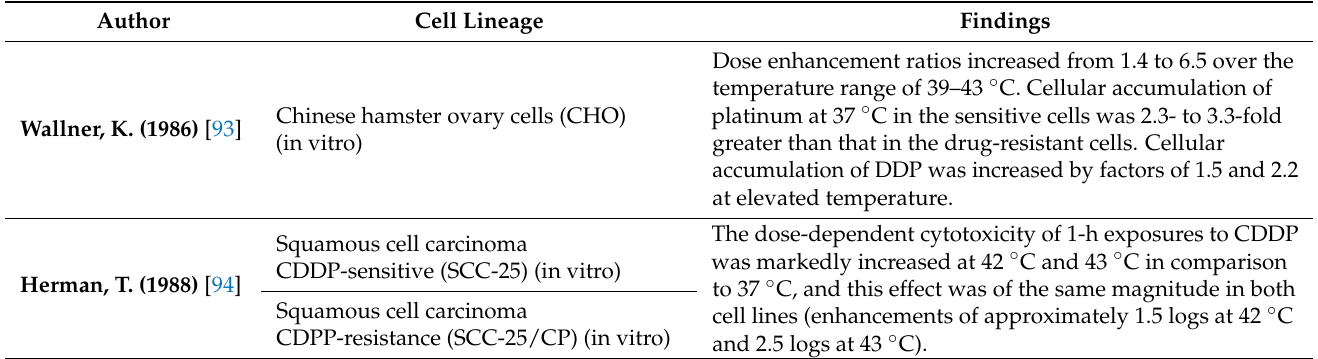
Table 2. In-vitro findings of the interaction of cisplatin and